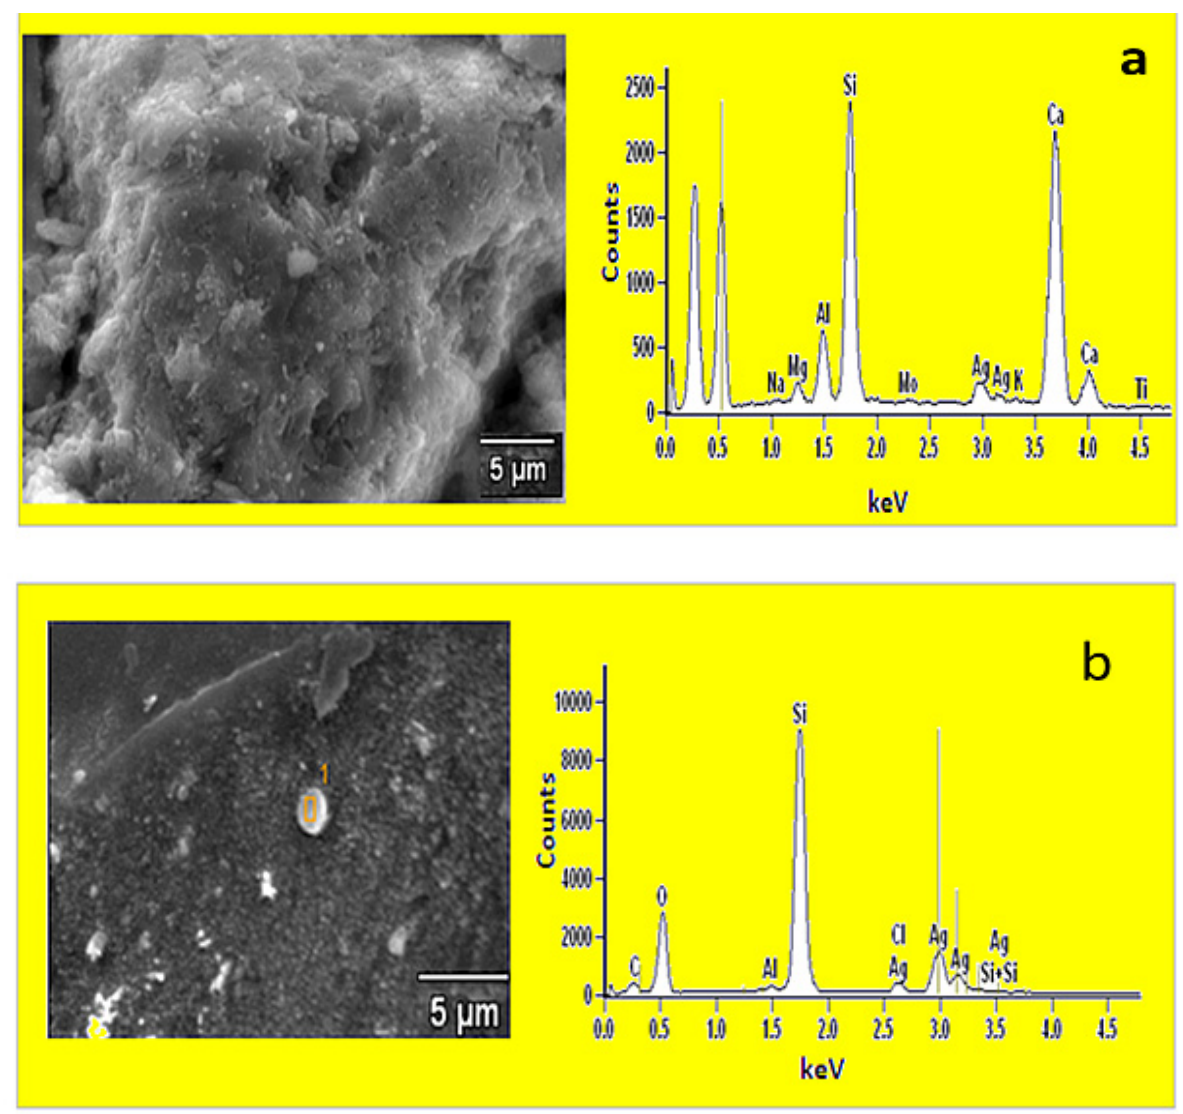
Figure 2. SEM image and EDS spectrum of ( a ) zeolite, ( b ) sand, ( c ) fibreglass, ( d ) anion resin, and ( e ) cation resin coated with silver